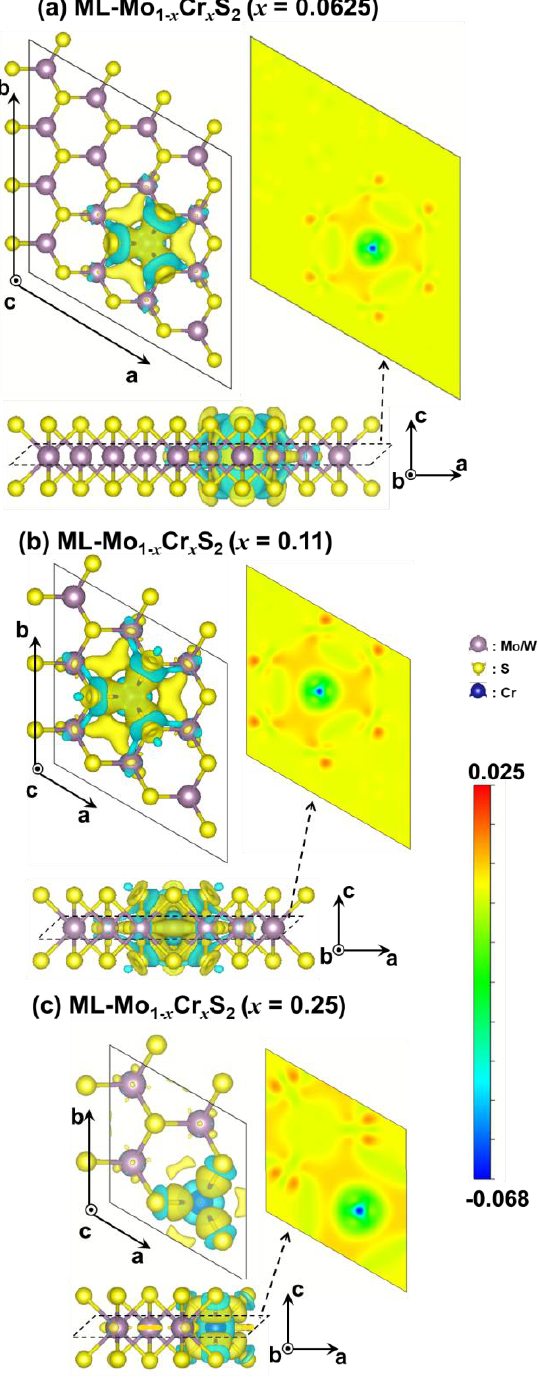
Figure 6. The charge transfer induced by the Cr atom in the ML-Mo 1- x Cr x S 2 under low and high mole fractions: ( a ) x = 0.0625, ( b ) x = 0.11, and ( c ) x = 0.25. The distributions of the charge difference were calculated by the following formula: CHG diff = CHG ML-Mo(1 − x )Cr( x )S2 – CHG ML-MoS2 – CHG Cr . The isosurfaces of the green and yellow colors indicate the loss and gain of electron charges, respectively. The plots of the cutting planes are at the height of the Cr atoms; the color bar represents the cutting planes. The distributions show that the S and Mo atoms near the Cr atom received extra electron charges owing to the repulsed electron charge by the Cr